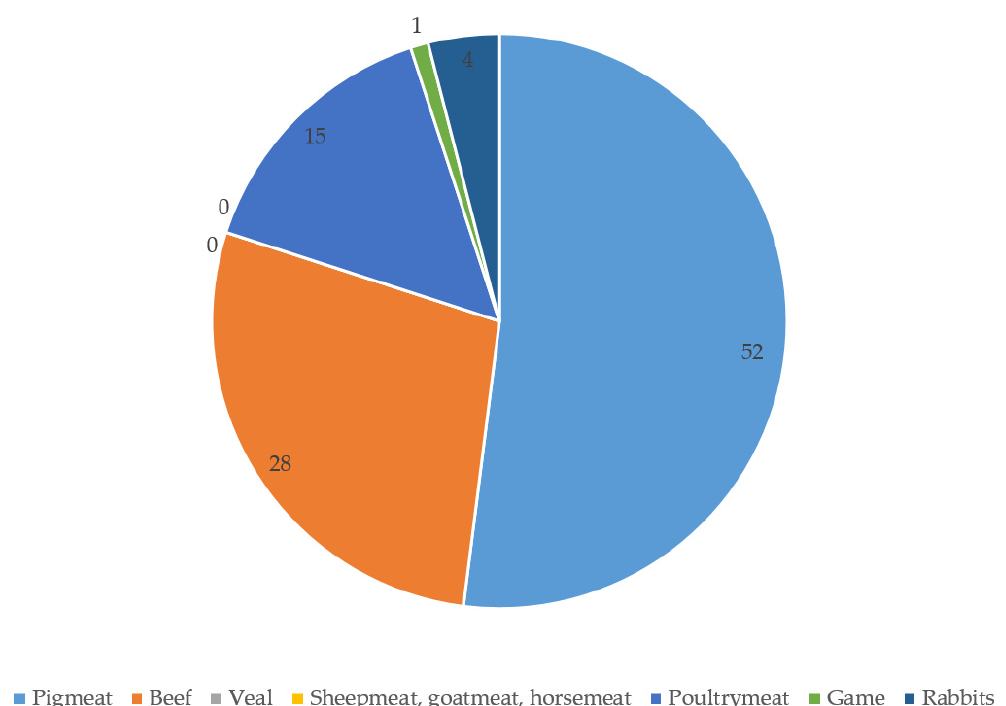
Figure 10. Share of meat consumption in 2000 in %